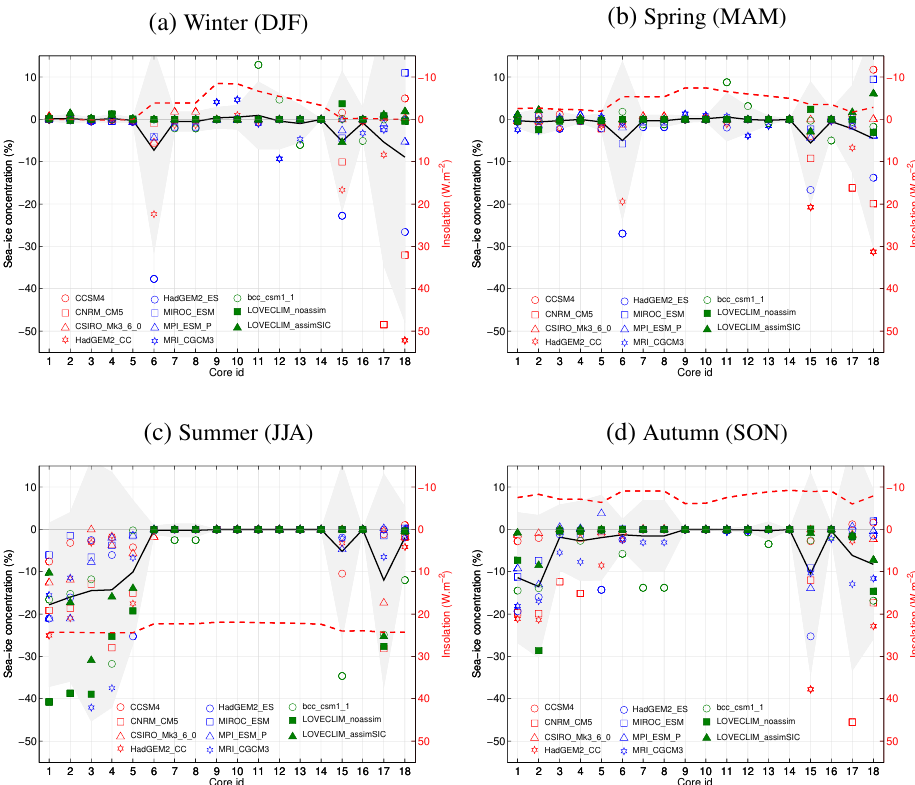
Figure 4. Mid-Holocene seasonal mean sea ice concentration anomalies (in %) for the climate model results corresponding to the core locations. The thick black line corresponds to the model mean. The grey shaded areas are the model mean ± 2 standard deviations. The dashed red line represents the seasonal mean insolation at each studied location (in Wm − 2 ) and corresponds to the reversed right axis. The reference period is